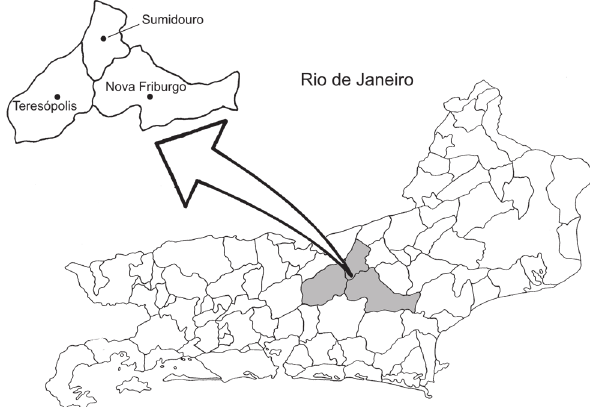
Figure 1. Map of the state of Rio de Janeiro with sampling sites in Nova Friburgo, Teresopolis and Sumidouro.